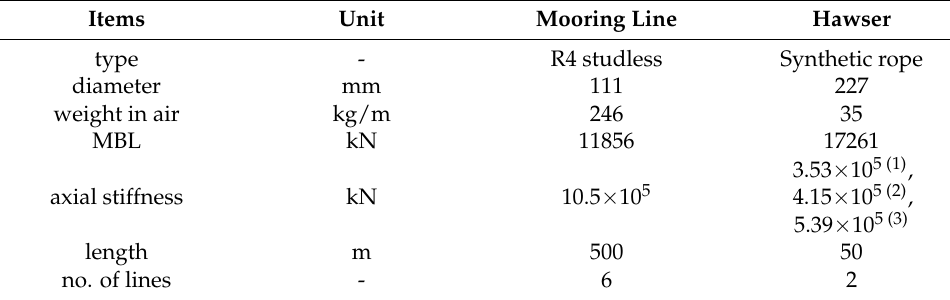
Table 7. Mooring and hawser line properties.